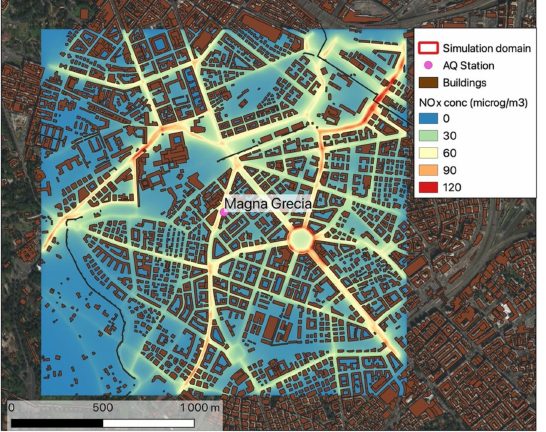
Figure 7. Average simulated NOx concentration in the month of May.